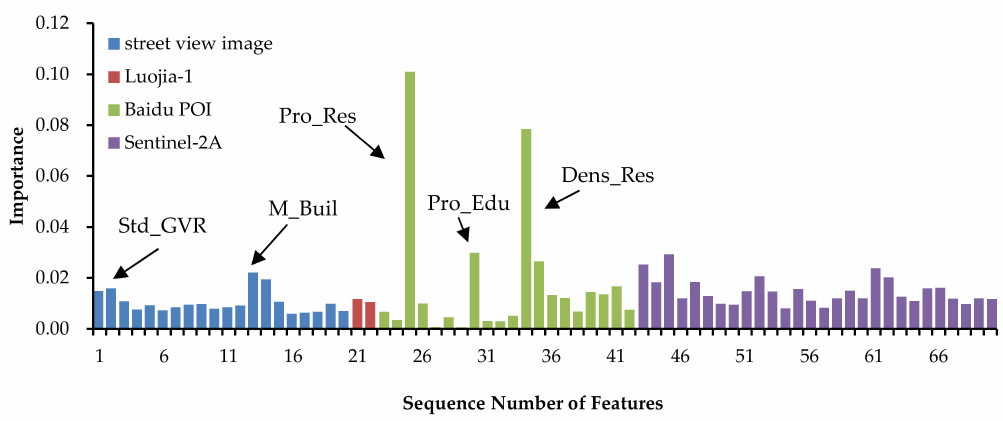
Figure 8. The importance of the di ff erent categories of features in the classification. Dens_Res: Density of residential points; M_Buil: Average value of building elements; Pro_Edu: Proportion of educational points; Pro_Res: Proportion of residential points; Std_GVR: Standard deviation of